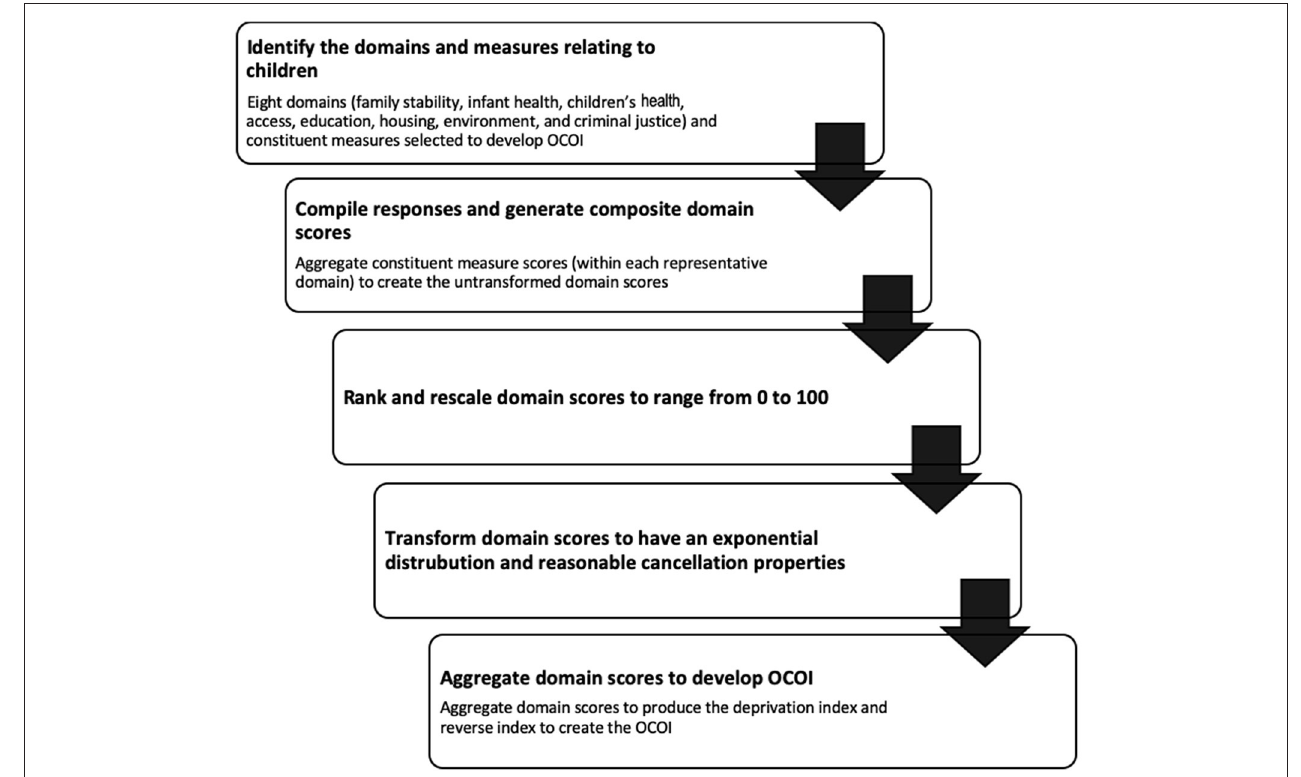
FIGURE 1 | Flowchart representing steps involved in developing the Ohio children’s opportunity index.